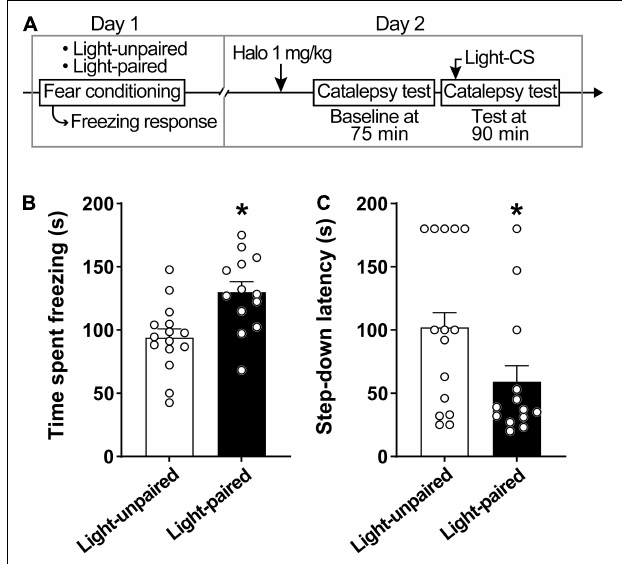
FIGURE 3 | Explicit paired light-CS disrupts haloperidol-induced catalepsy. (A) Timeline of the experimental procedure. (B) Freezing response during fear acquisition session in rats receiving light-CS and footshock-US paired explicitly (Light-paired), or randomly presented (Light-unpaired). (C) Effects of explicit paired Light-CS or unpaired on haloperidol-induced catalepsy, verified 90 after drug administration (1 mg/kg haloperidol). Marginal estimated means + S.E; circles represent individual animals. *Different from the Light-unpaired group. n = 15 for Light-unpaired group; n = 13 for Light-paired